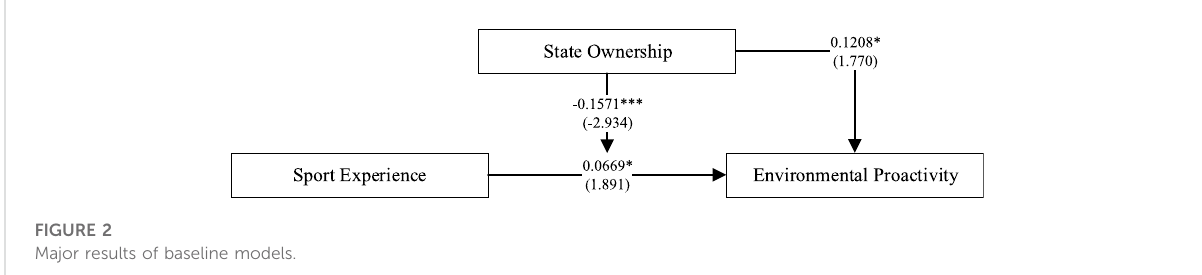
FIGURE 2 Major results of baseline